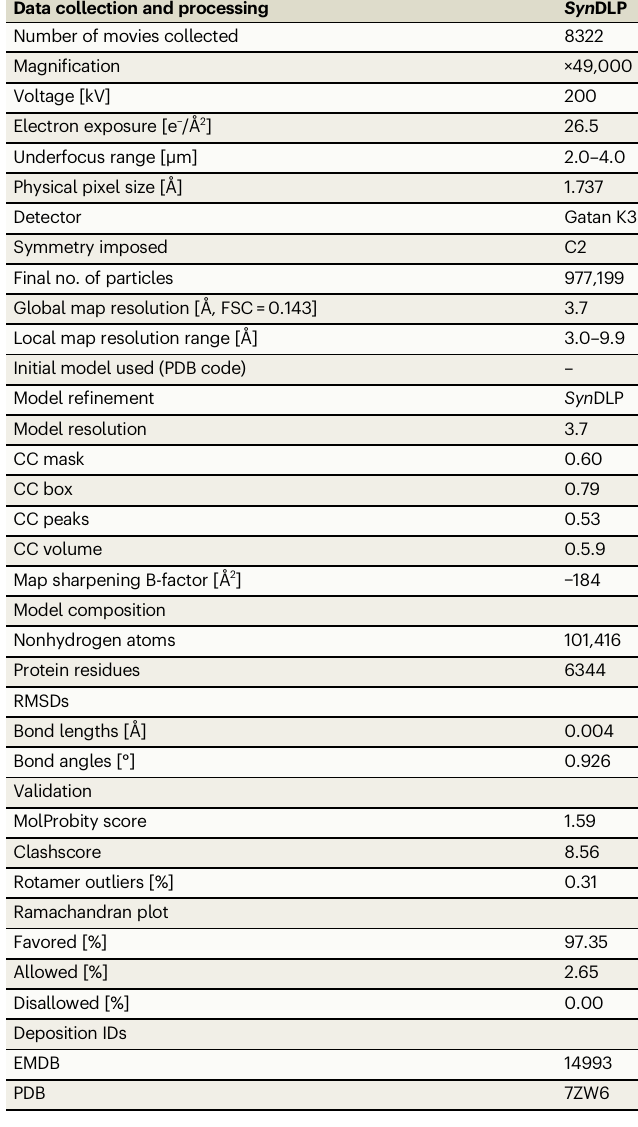
(blue). f Secondary structure topology plot of Syn DLP with additional α -helices of the enlarged Syn DLP GD colored in orange. g Model of a Syn DLP octamer high- lighting the sequentialarrangement of monomerswithinthe oligomer.Alternating monomers are colored in green and orange, respectively. h Model of the Syn DLP monomer, including structural features. GD, BSE and stalk are colored as in ( e ). Zoomed insets show the HPRN loop with the electrostatic surface of neighboring monomers, two putative lipid-binding sites at the tip of the stalk colored in magenta and green, respectively, and conserved motifs in the nucleotide-binding siteoftheGD:P-loop,switchI,switchIIandG4motifcoloredingreen,orange,cyan and pink, respectively.